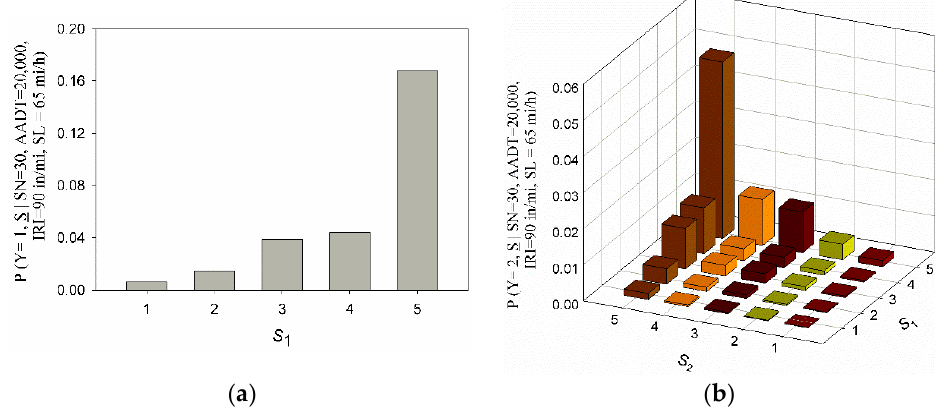
Figure 11. Probability of having ( a ) one crash a year with various severity levels and ( b ) two crashes a year with various severity combinations.